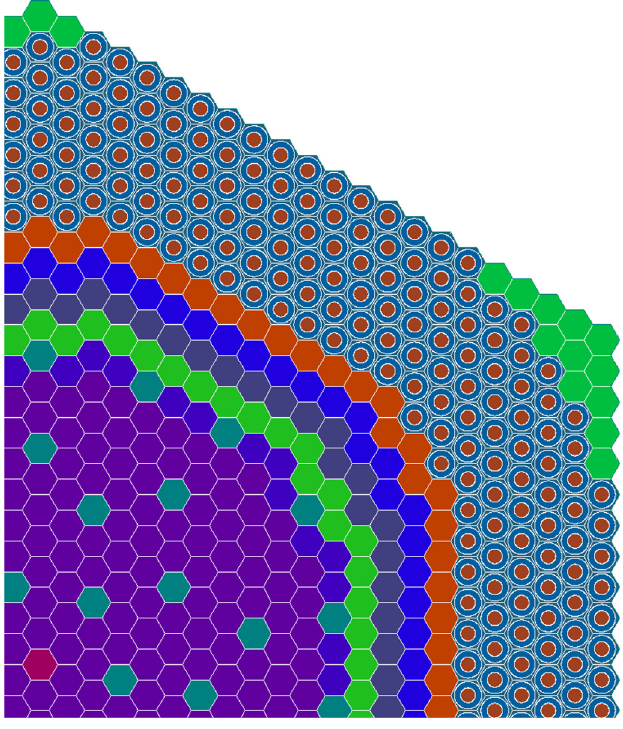
Fig. 16. Semi-heterogeneous description of the ASTRID